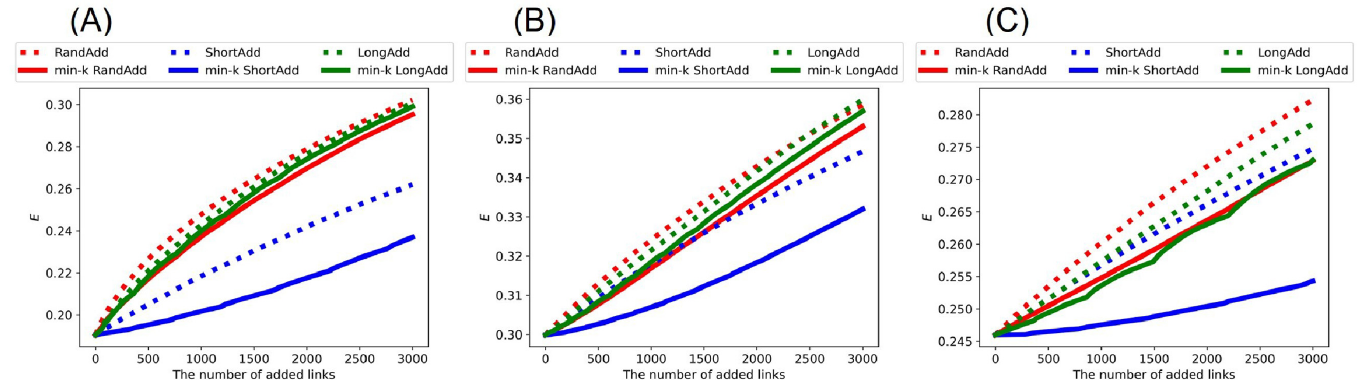
Fig 15. Network efficiency after adding links to real networks. The RandAdd method (red dotted line) is the most effective for increasing E among six methods. The min- k ShortAdd method (blue solid line) is lower than the other five methods. The initial networks are (A) AirTraffic, (B) Email, and (C) Yeast. The correspondence between lines and methods is the same as shown in Fig